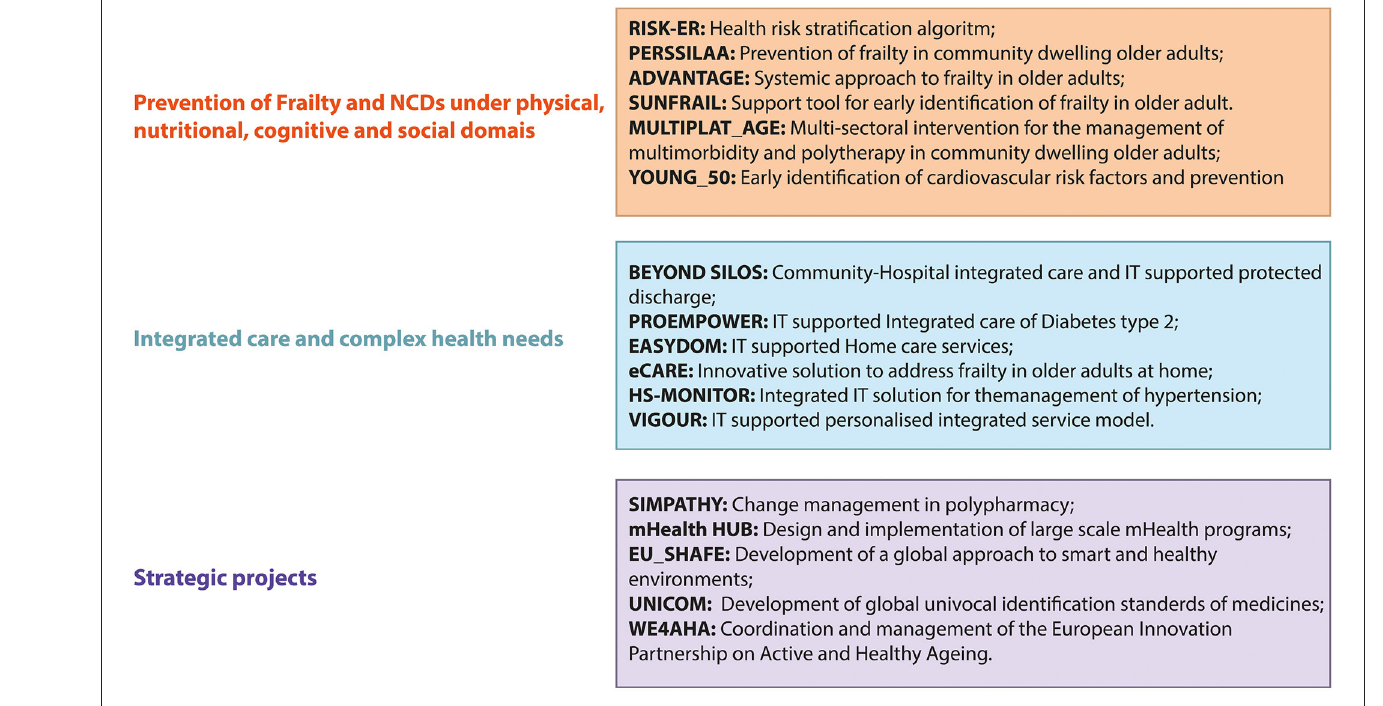
FIGURE 2 | International projects involving Campania’s